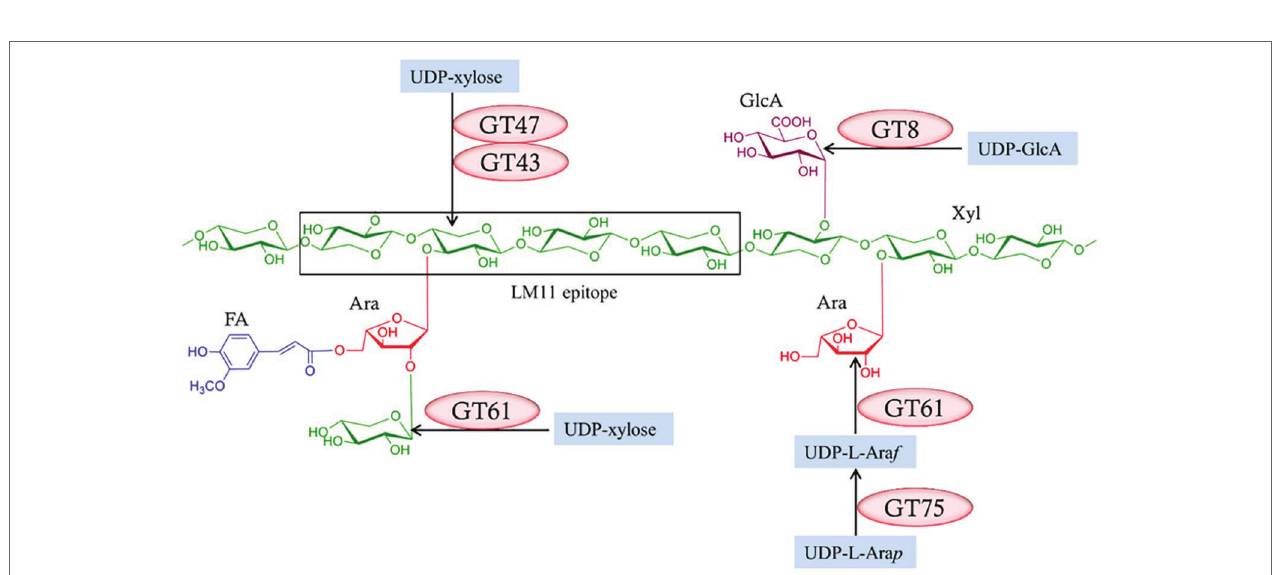
FIGURE 5 | Chimeric constructs of the sorghum and barley CslF6 enzymes. When the HvCslF6 NH 2 -terminal section was replaced with the homologous region of the SbCslF6 enzyme, the amount of (1,3;1,4)- β -glucan synthesized increased in the heterologous expression system, while interchange of the sections indicated closer to the COOH-terminus changed the DP3:DP4 ratios (Dimitroff et al., 2016).